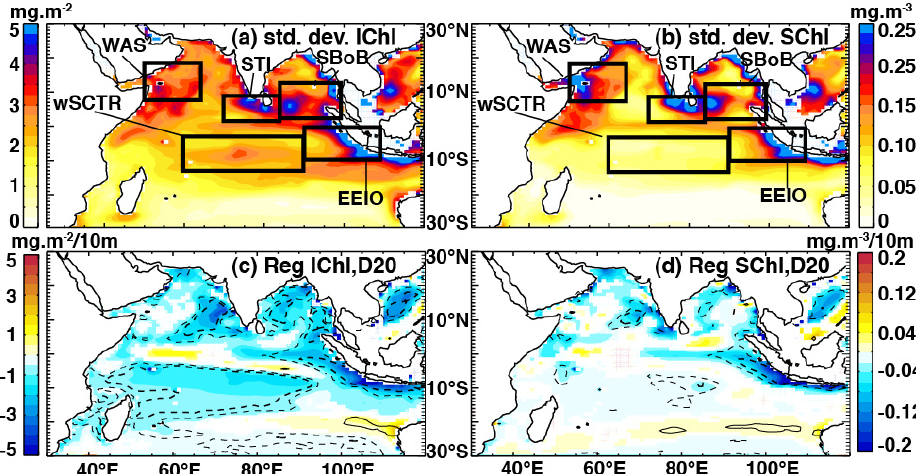
Fig. 6. Regional interannual variance of (a) I Chl and (b) S Chl, as indicated by the standard deviation of their anomalies over the period 1961– 2001. (c) Coefficients from a simple linear regression of I Chl and (d) S Chl anomalies regressed onto D20 anomalies over the same period. Regression coefficients were drawn only when beyond a 90% significance level. Thin and thick contours indicate correlation coefficients of 0.4 and 0.6 respectively, while solid (dashed) lines represent positive (negative) coefficients. Geographical boxes used in later analyses and selected on the basis of regional biogeochemical variability are shown in (a) and (b)